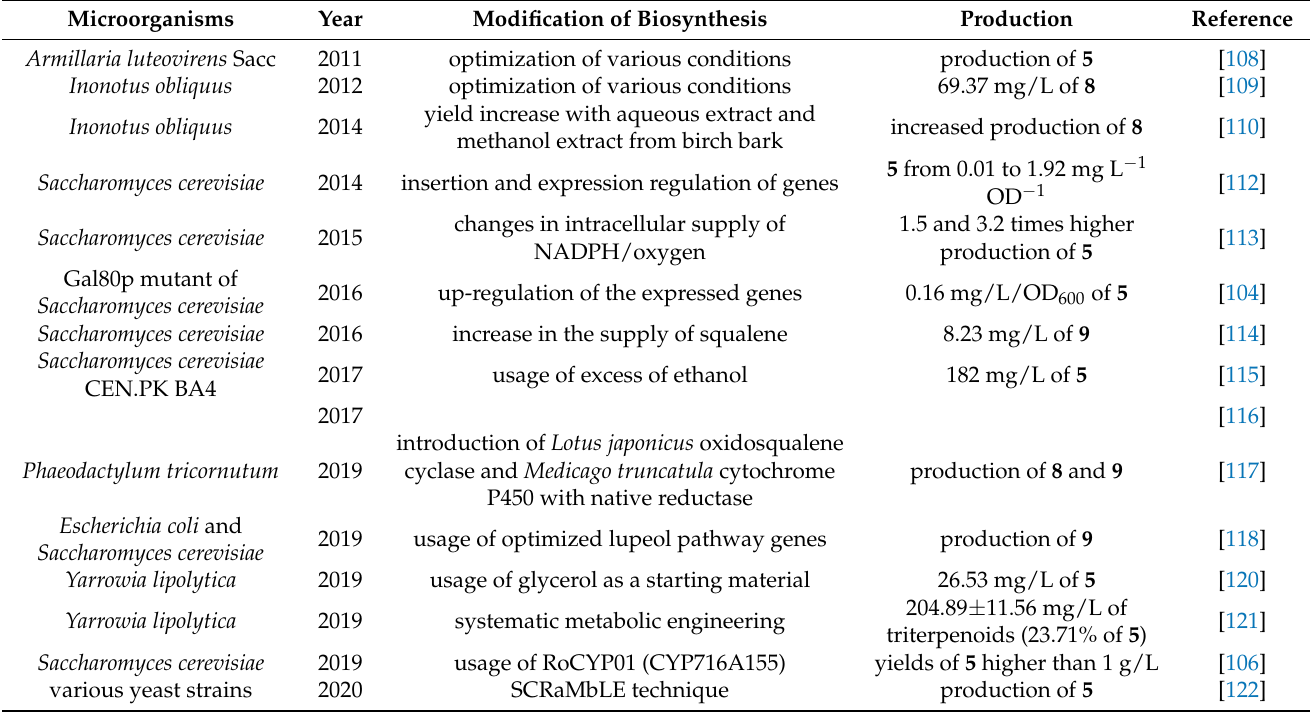
Table 2. Biocatalyzed production of lupane